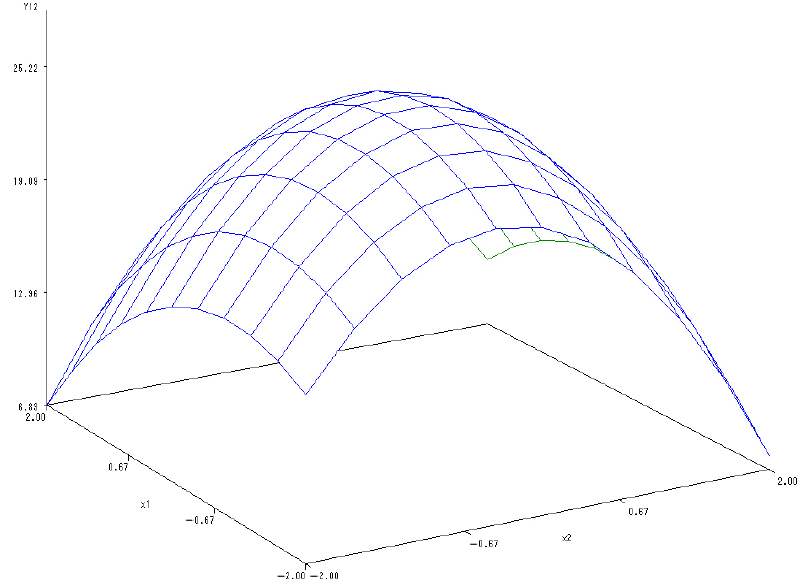
Figure 5. The 3 ‐ D map of mutual effect of N and P fertilizers application on the content of Vc in Figure 5. The 3-D map of mutual effect of N and P fertilizers application on the content of Vc melon. in melon.